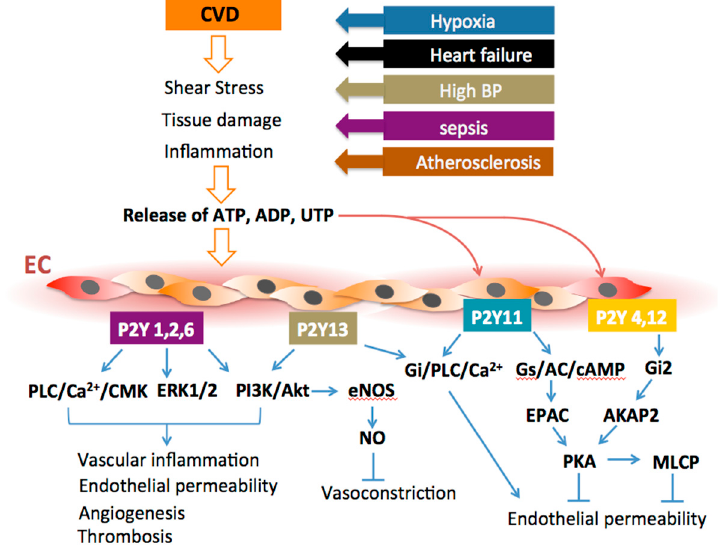
Figure 6. Overview of the molecular mechanisms and endpoints on the involvement of endothelial P2Y receptors in cardiovascular disease (CVD). Pathological responses to CVD include the release of extracellular purines at the sites of injury, following by activation of P2Y receptors and specific P2YR-mediated intracellular pathways leading to either injury progression, resolution, or both in tissue- and agonist-specific manner.